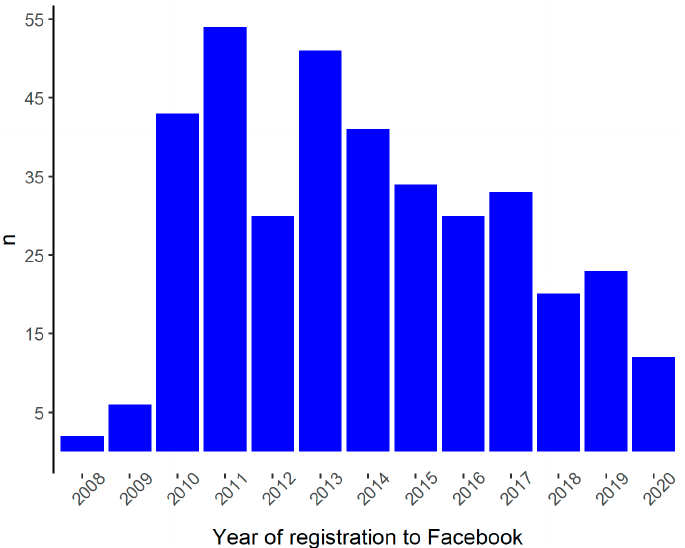
Figure 4. The intensity of the color of the vertical bars refers to the frequency (%) of the categories and increases in a mirror image of the colored bar in the center.